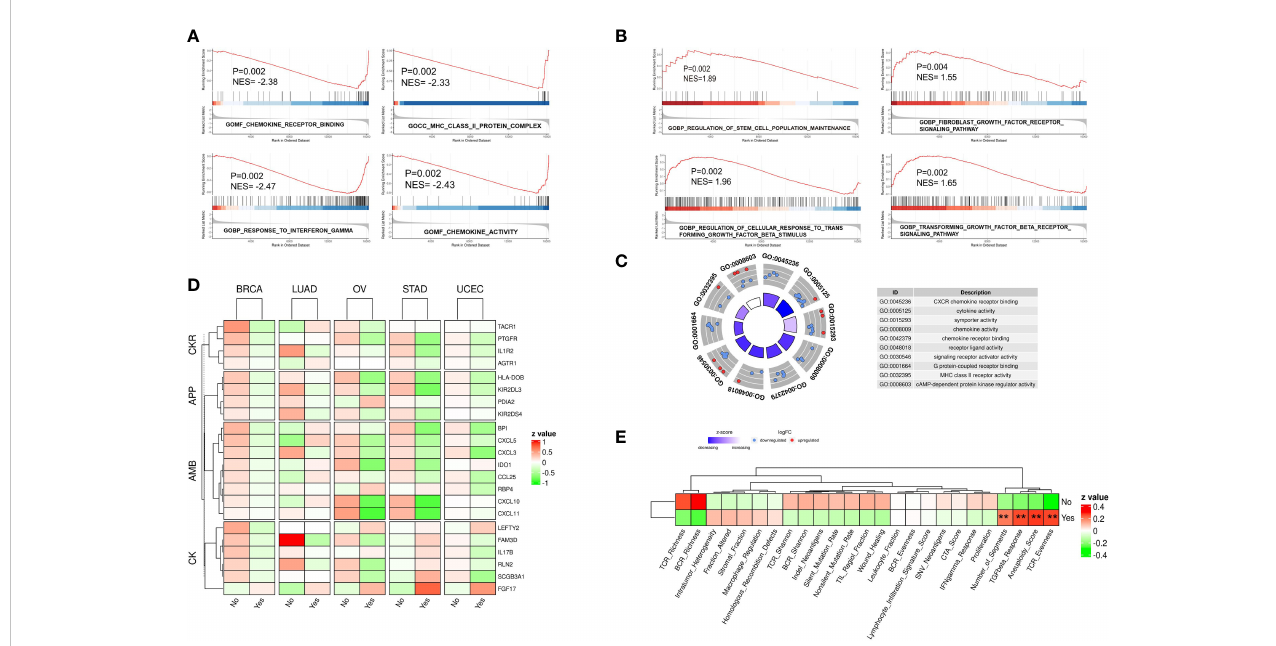
FIGURE 1 Gene expression pro fi le of fi ve types of cancer con fi rmed for chromothripsis status. (A) GSEA analysis reveals down-regulated pathways related to anti- tumor immunity in chromothripsis group. (B) GSEA analysis indicates up-regulated pathways related to tumor immune suppression in chromothripsis group. (C) GO analysis reveals enrichment of DEGs in cancer immune or protein interaction categories. (D) Expression of immune regulatory genes belonging to Chemokines (CK), Antimicrobials (AMB), Antigen processing and presentation (APP), and Cytokine receptors (CKR) in chromothripsis and non-chromothripsis groups of in fi ve cancer types. (E) Immune cell activation signature in chromothripsis and non-chromothripsis groups. **p <